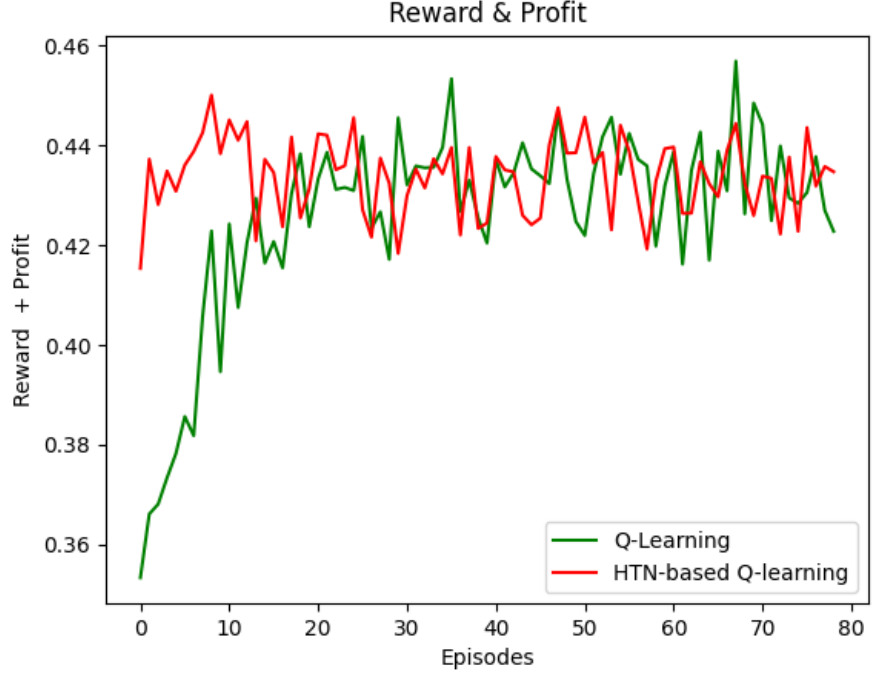
Figure 6. Convergence time—Reward vs.